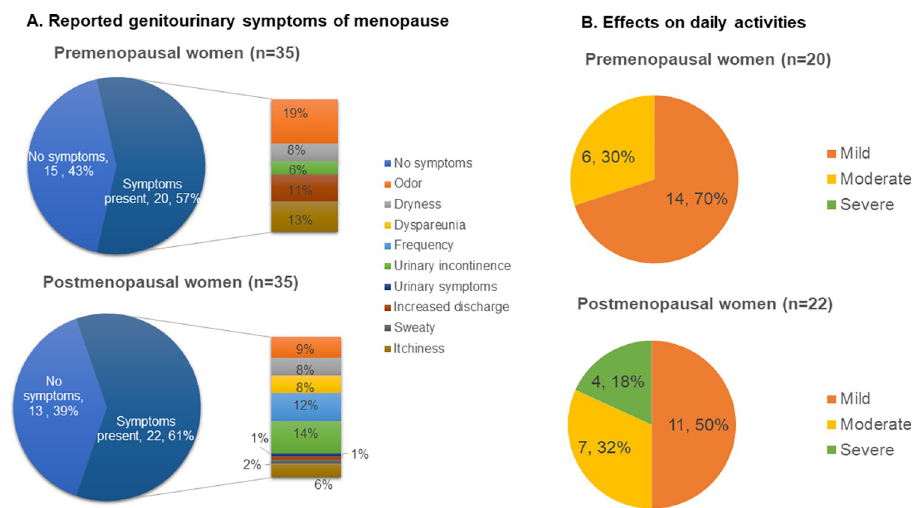
Fig 2. Self-reported genitourinary symptoms and their effects on daily activities. Genitourinary symptoms were more varied and stronger in postmenopausal women. Changes after four weeks.